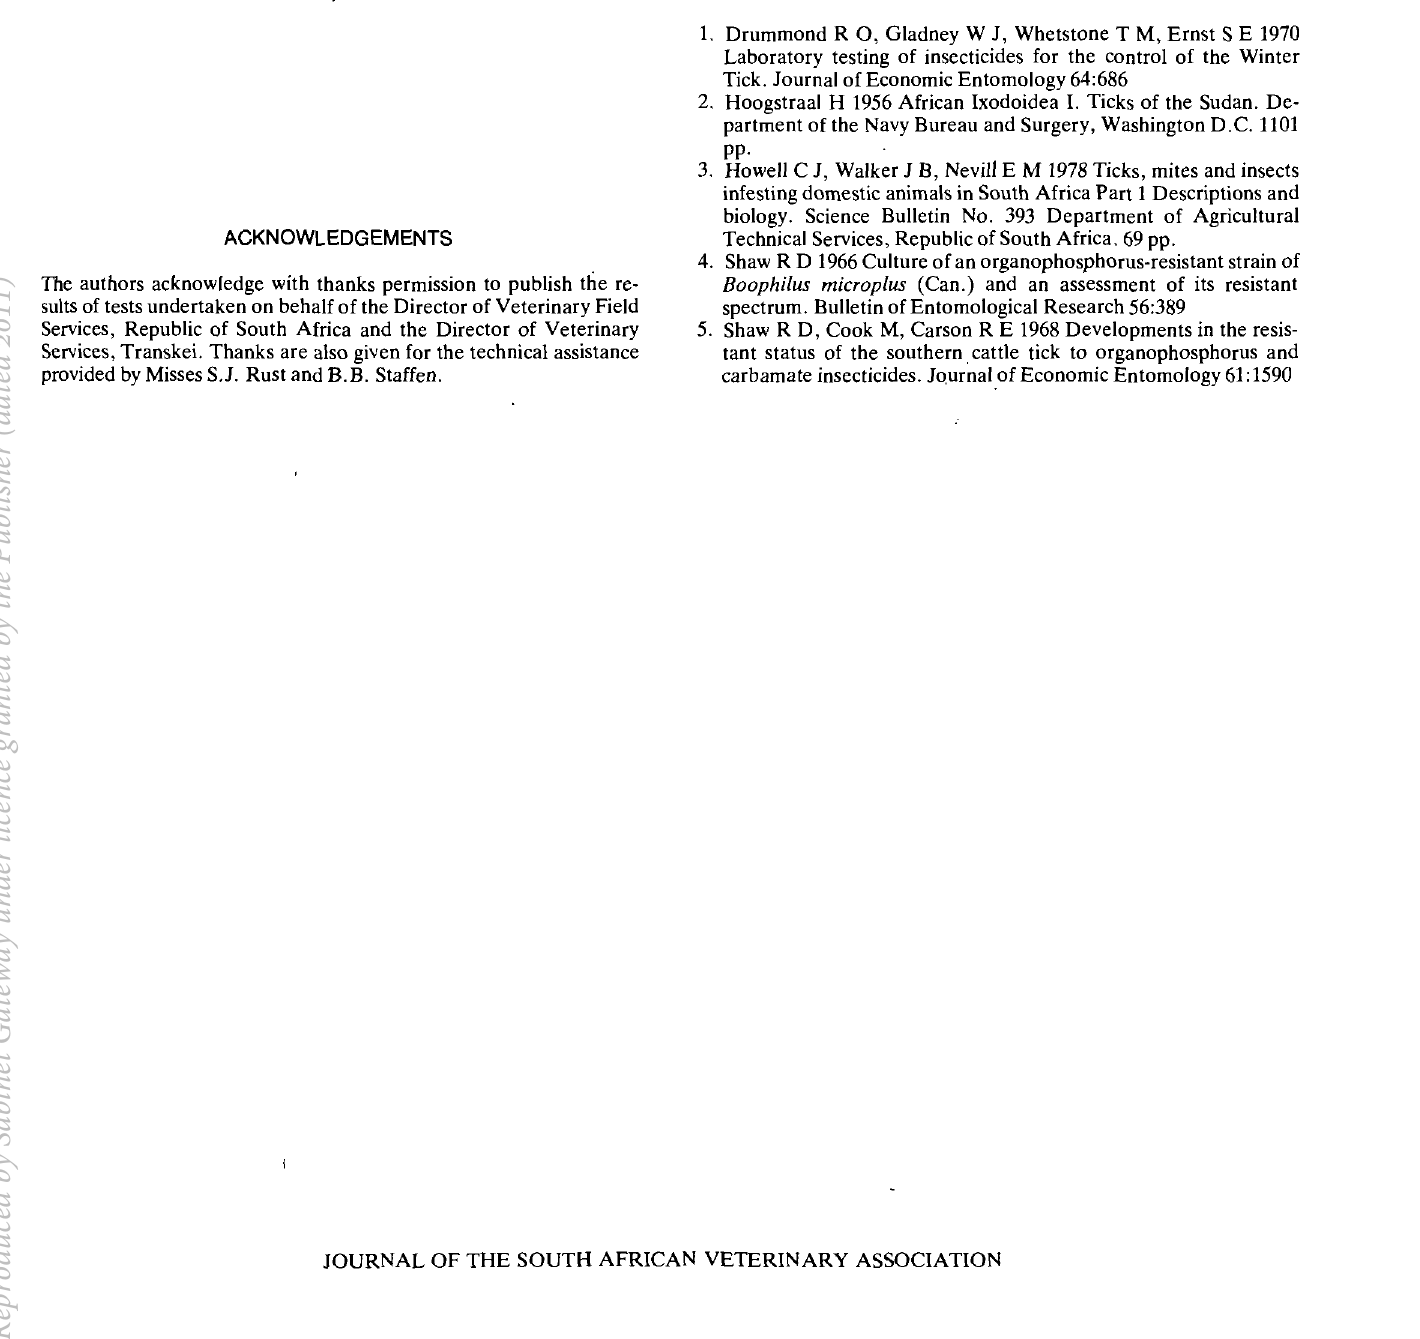
Fig. 5. A comparison of the effect of two different ixodicides on the viability of egg batches laid by engorged females of two strains of Boophilus